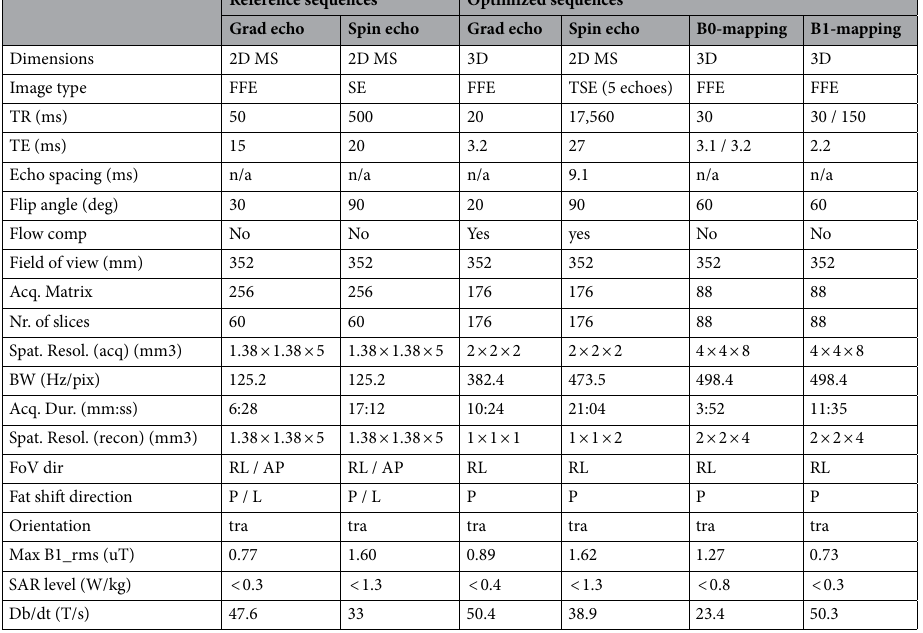
Table 1. Main imaging